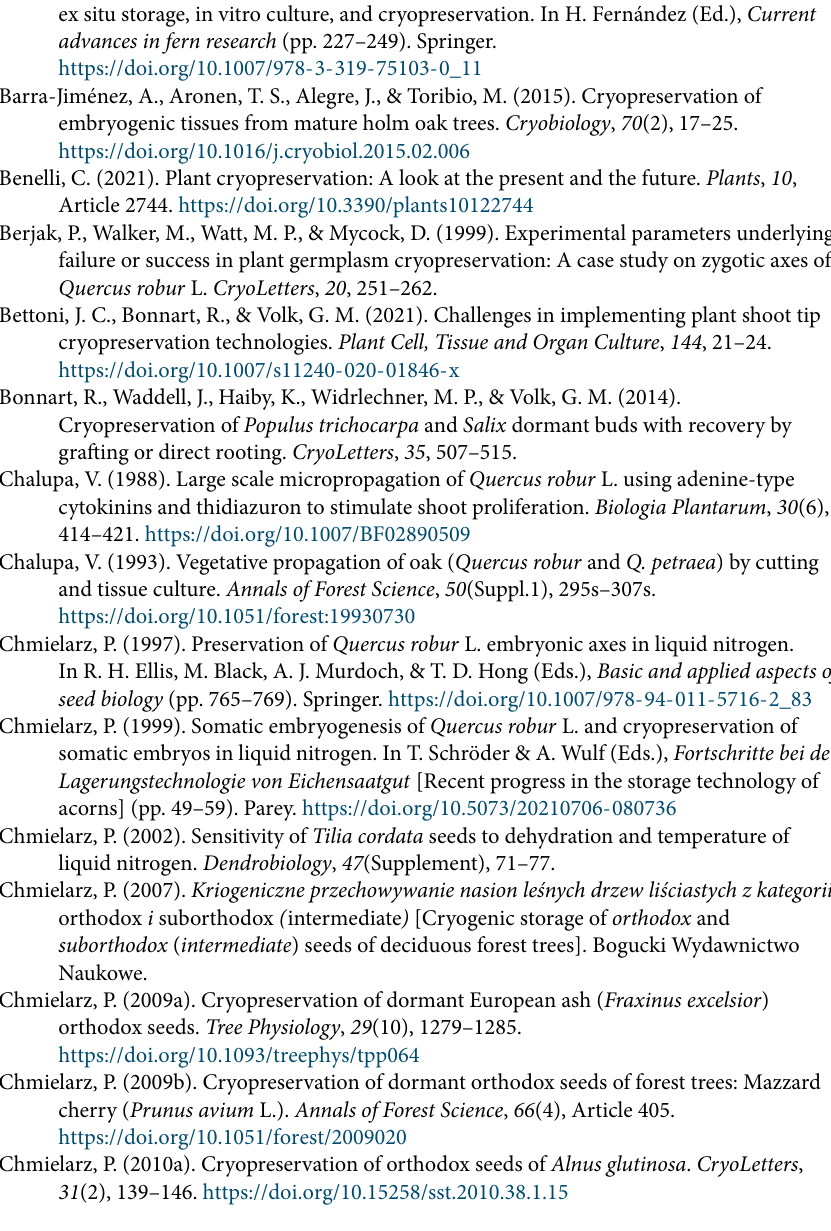
Table S3. Ferns stored as gametophytes in cryobanks